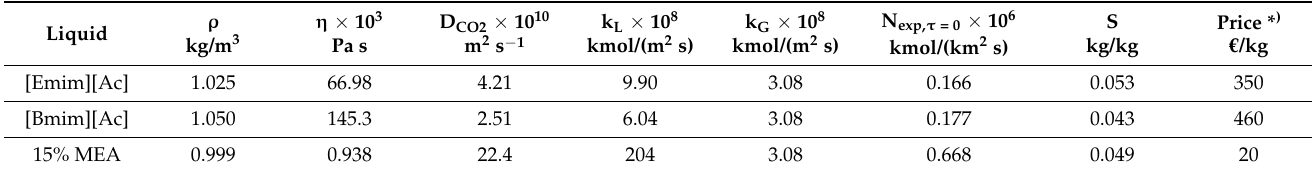
Table 1. The physical parameters of the CO 2 absorption process in a packed